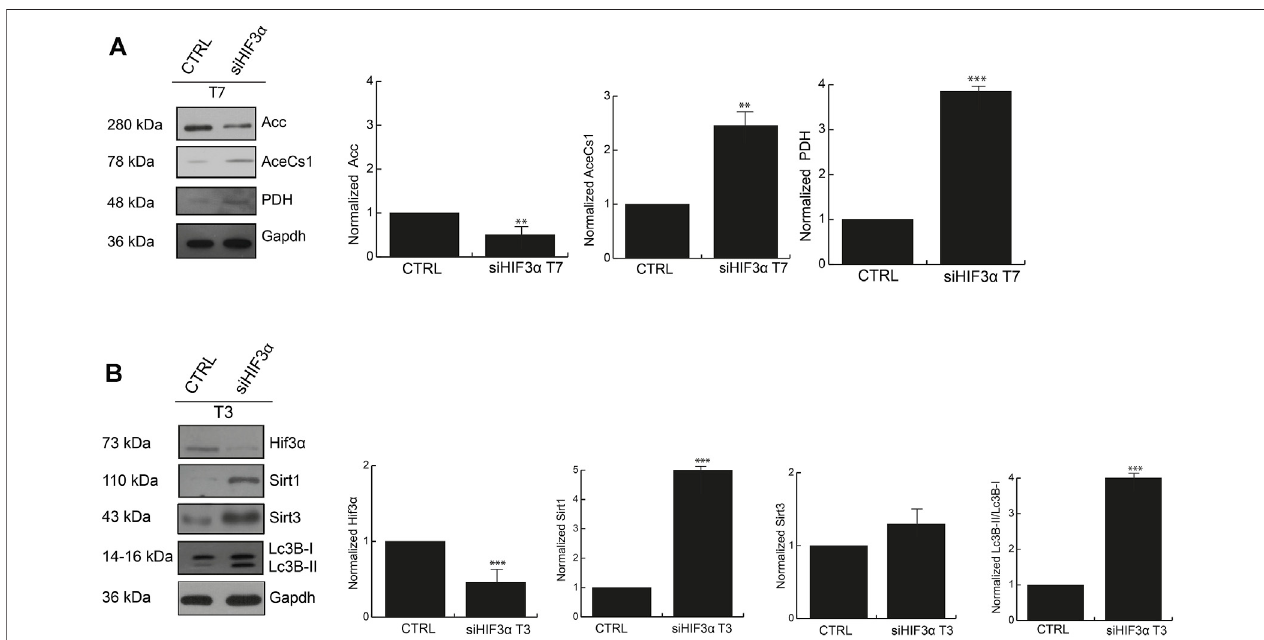
FIGURE5| Theinhibitionof Hif3 α inducesfattyacidssynthesisenzymes (A) WesternblotanalysisofAcc,AceCS1andPDHinsi Hif3 α after7 daysofdifferentiation induction. SIRTs are activated in absence of Hif3 α (B) Western blot analysis of Hif3 α , Sirt1, Sirt3 and Lc3B-I/II detected in si Hif3 α adipocytes at T3. Densitometry values are mean ± SEM of biological triplicates and are graphed as normalized for relative housekeeping (Actin or Gapdh) using the ImageJ Gel Analysis tool and expressed as fold change. Gapdh was showed as representative housekeeping. ( n (cid:2) 3; *** p ≤ 0.001, ** p ≤ 0.01 vs . control cells).